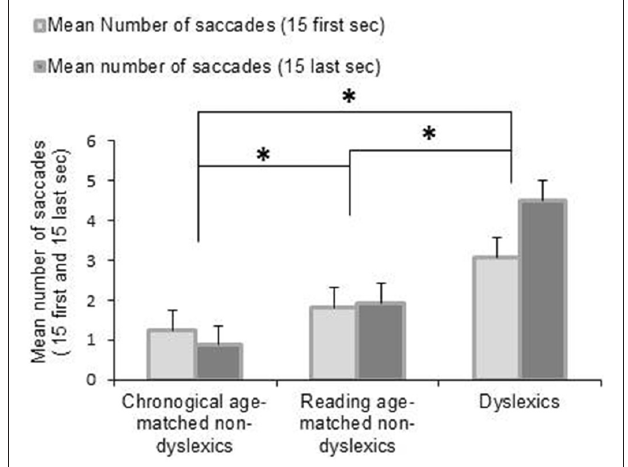
FIGURE 2 | Mean values of number of saccades during fixation task for the first 15 and the last 15 s. Vertical bars indicate the standard error. Asterisk indicates a significant difference between the three groups of